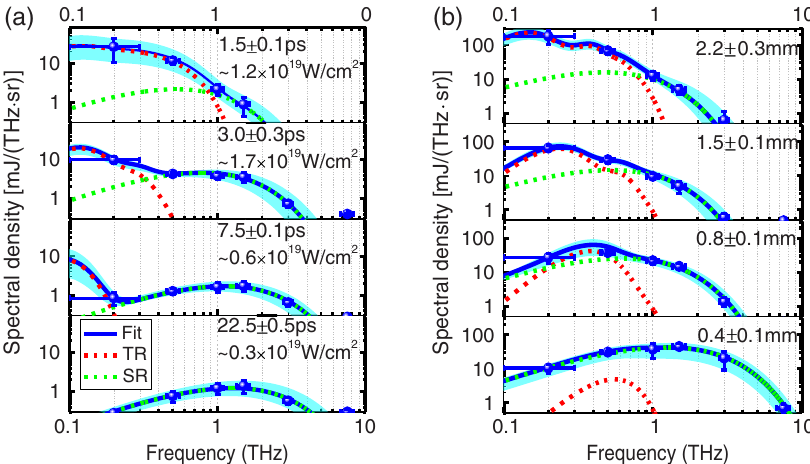
FIG. 2. Experimental results and theoretical fitting. (a) THz spectra for given laser pulse durations and intensities at a constant target size of about 3 mm. (b) THz spectra for different target sizes under similar laser conditions (laser energy of about 70 J and pulse duration of about 1.5 ps). Circles are the experimental data. Solid curves are fits using the analytical models described in the preceding section. Dashed curves correspond to the decomposition of the resultant THz spectra into the TR (red) and SR (green) components, and the cyan band shows the fitting range to cover the errors in the experimental data (see Sec. VII for details on the spectral measurements and fitting). Vertical error bars are a combination of the shot-to-shot fluctuations in the drive laser parameters and the measurement uncertainty in the detectors. Horizontal error bars represent the transmission bandwidth of the filters